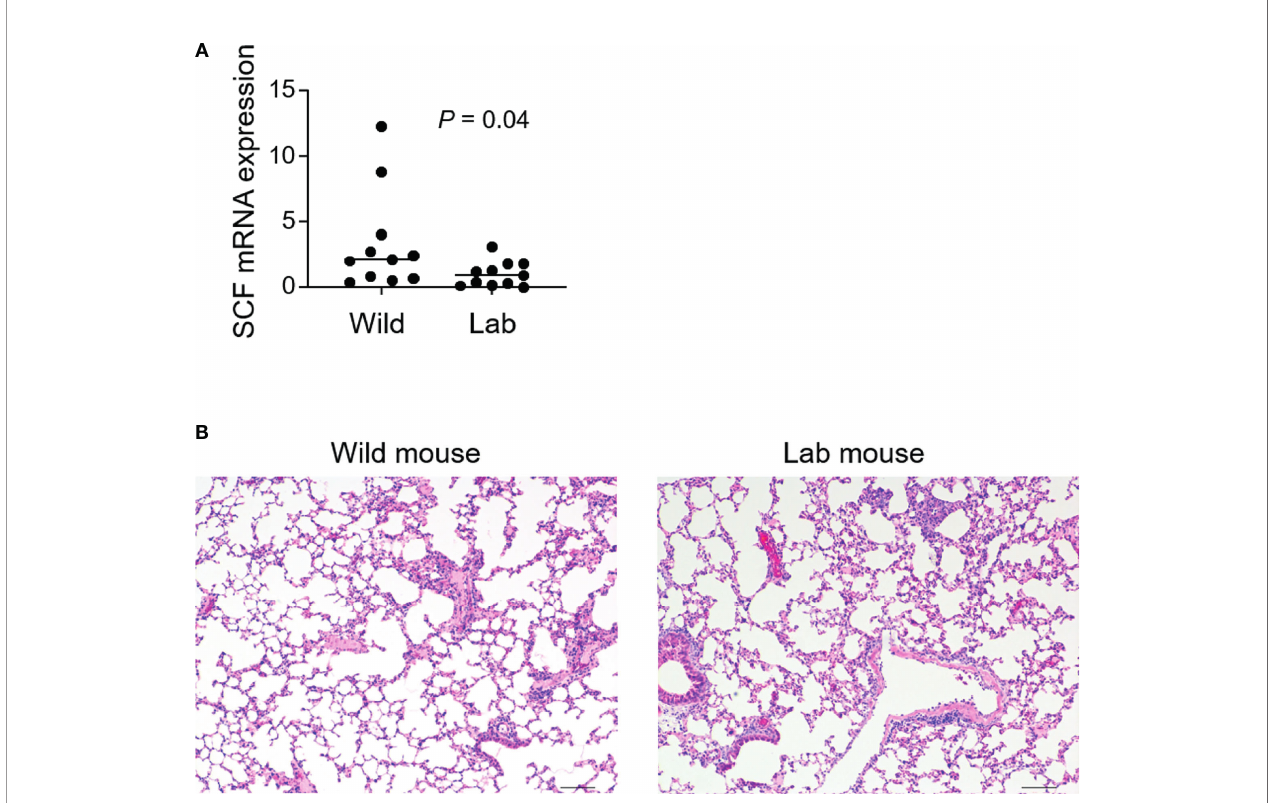
FIGURE 3 | Higher levels of SCF are identi fi ed in wild mouse lungs which show similar overall histological features as laboratory mice. Free-living wild mice were trapped at Hemtabad, India. (A) RNA was puri fi ed from formalin- fi xed paraf fi n-embedded (FFPE) lung tissues of both wild mice ( n = 11) and C57BL/6 laboratory (lab) mice ( n = 11), followed by cDNA synthesis. Levels of mRNA expression of SCF were assessed using quantitative reverse transcription PCR. SCF expression was normalized relative to the expression of GAPDH. Each dot represents an individual mouse and horizontal lines indicate the median. (B) Lung tissues from wild mice together with lab control mice were processed and sectioned for H&E staining. Shown are the representative images. Scale bar: 100 m